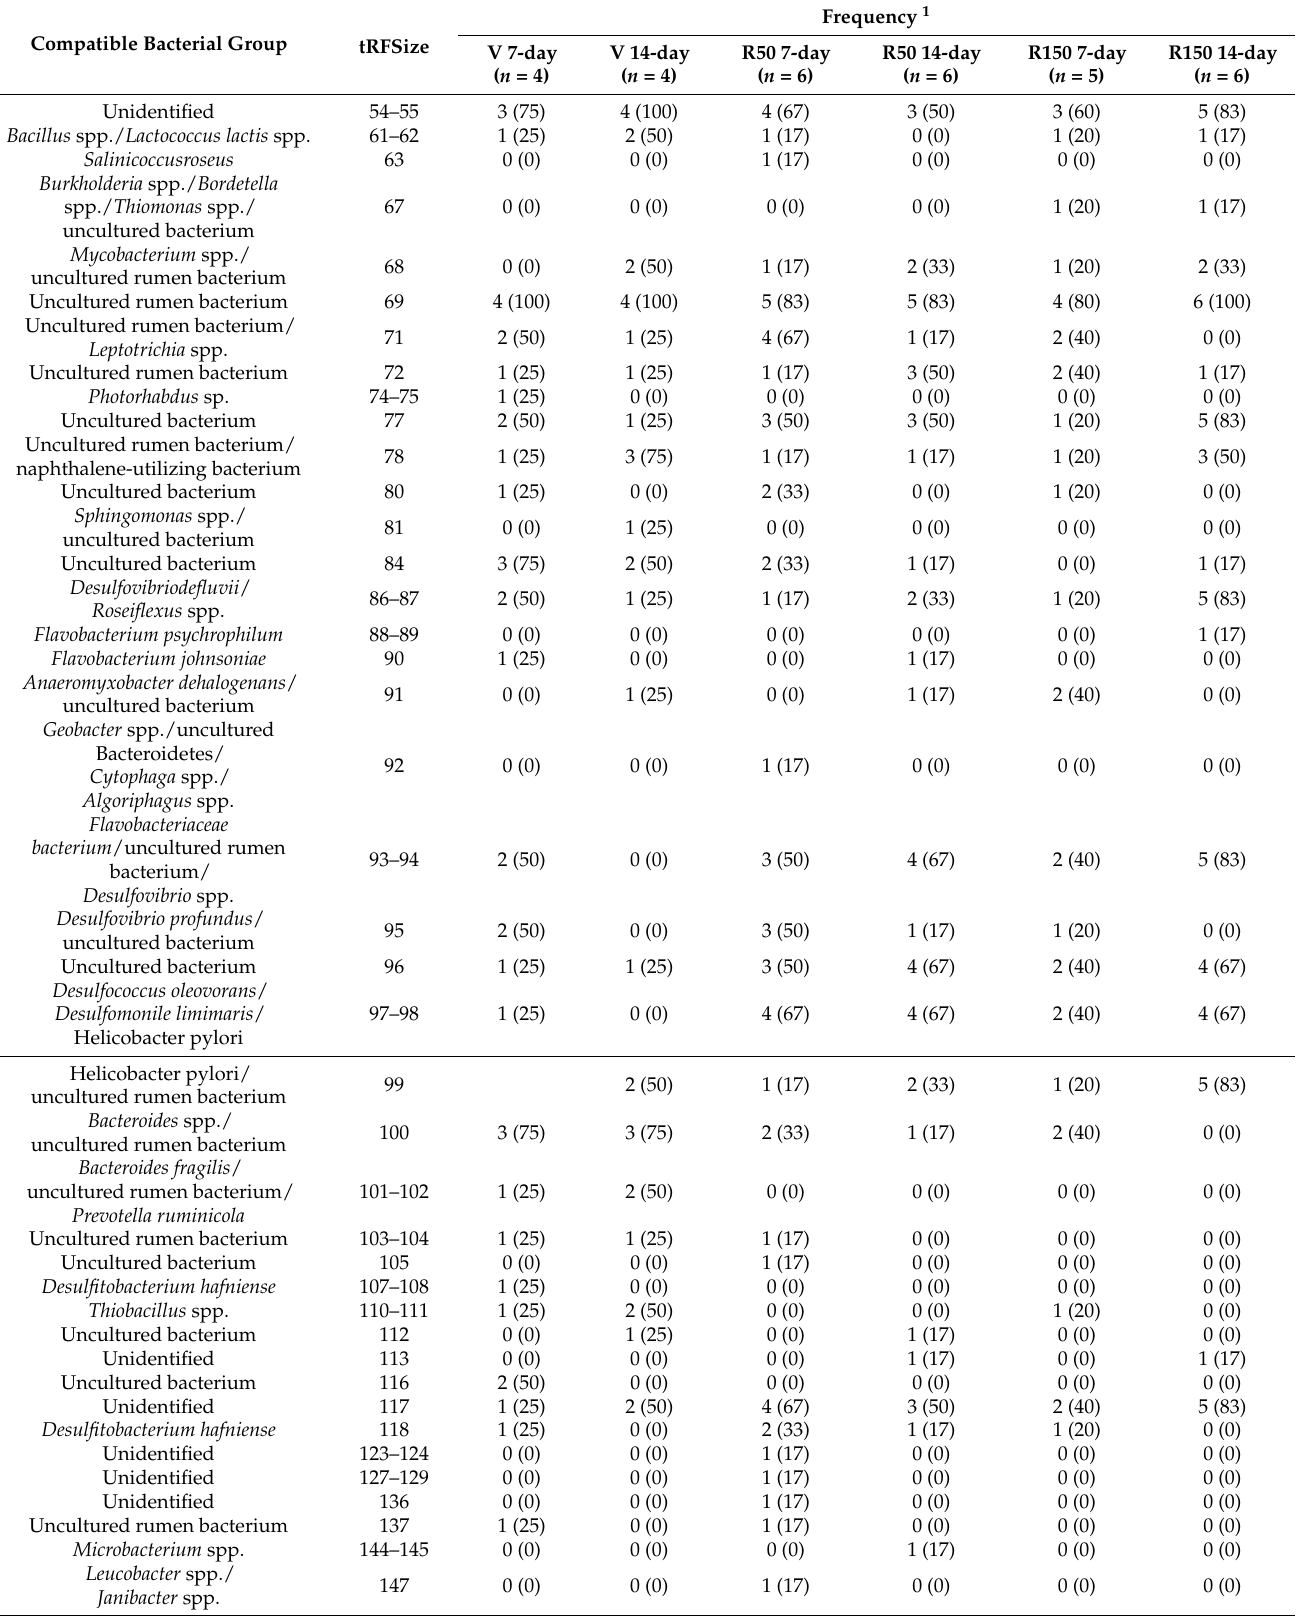
Table 2. Theoretical restriction 5 (cid:48) -fragment (tRF) size predicted for the major mouse gut bacteria and prevalence in the different experimental